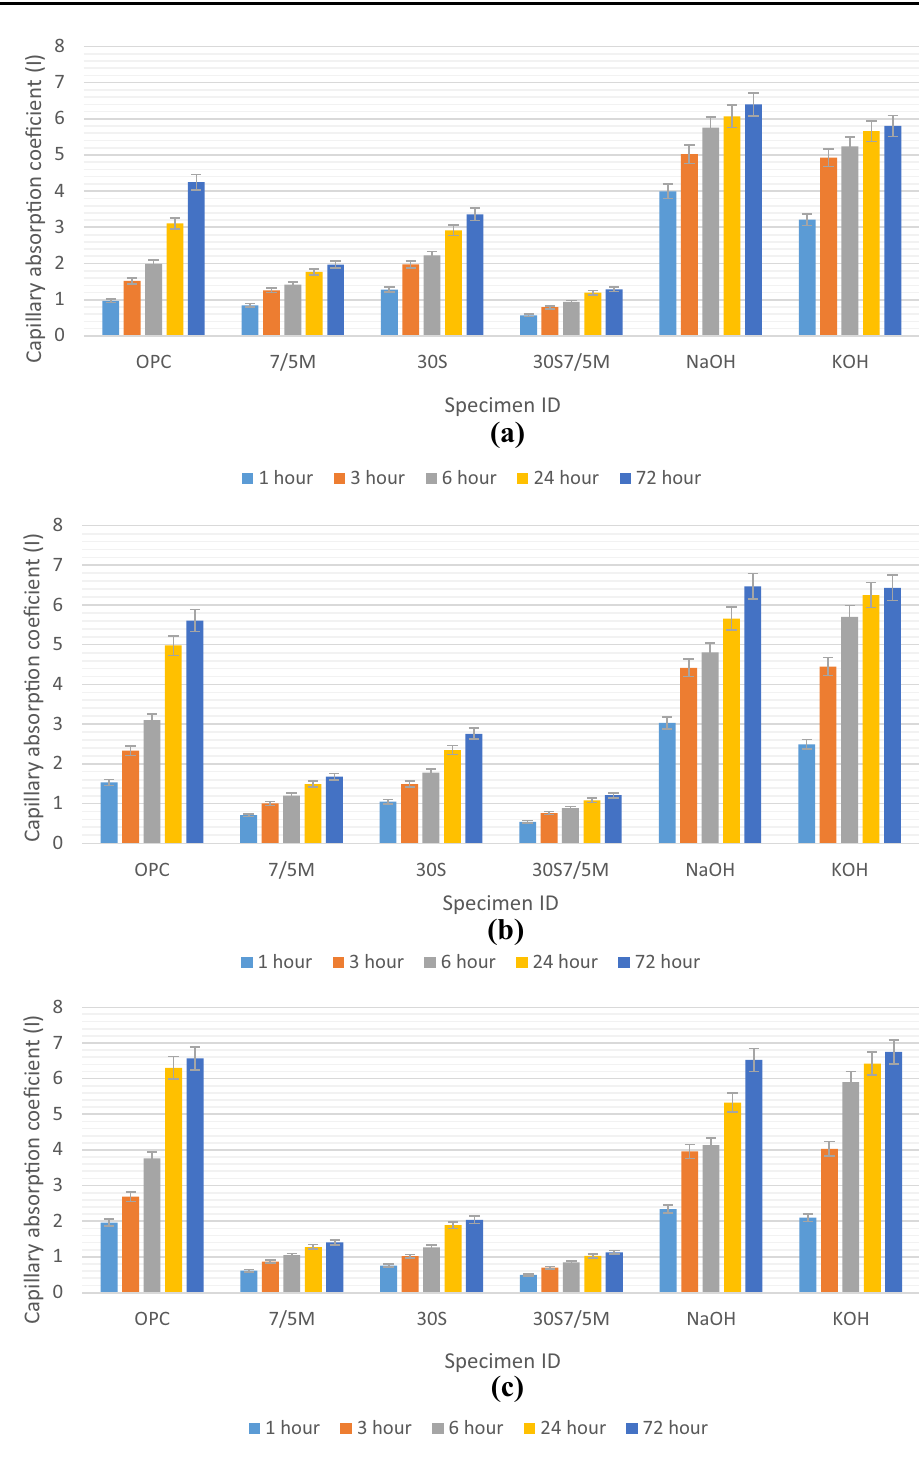
Fig. 14 The capillary absorp- tion coefficient at the age of 28 ( a ), 56 ( b ), and 90 ( c )